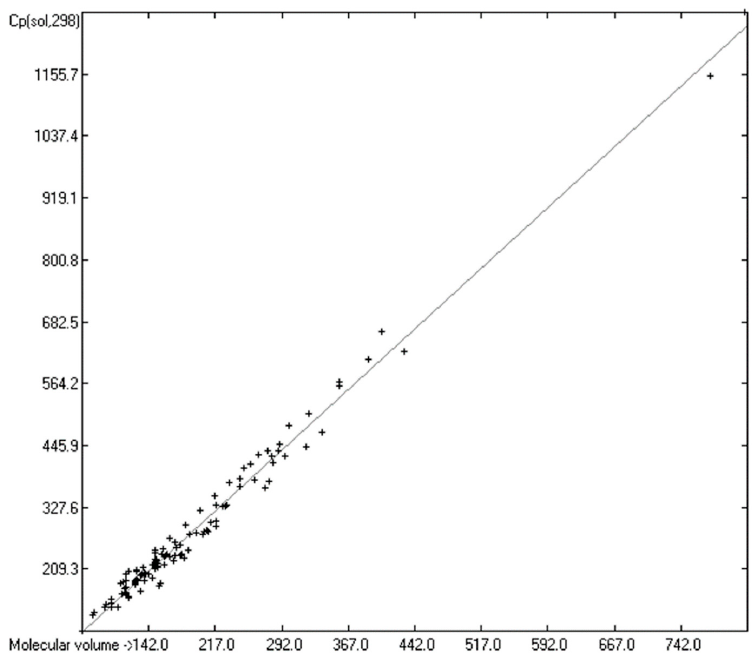
Figure 14. Correlation of molecular volumes with Cp(sol) at 298.15 K of polyols and polyacids. (N = 119, R 2 = 0.9866, σ = 19.75 J/mol/K, MAPD = 5.93%, regression line: intercept = − 14.9656, slope = 1.5462, value range from 91 to 1273 J/mol/K). Table 11. Experimental and Equation (5)-calculated Cp(sol.298) of 9 metallocenes in J/mol/K.